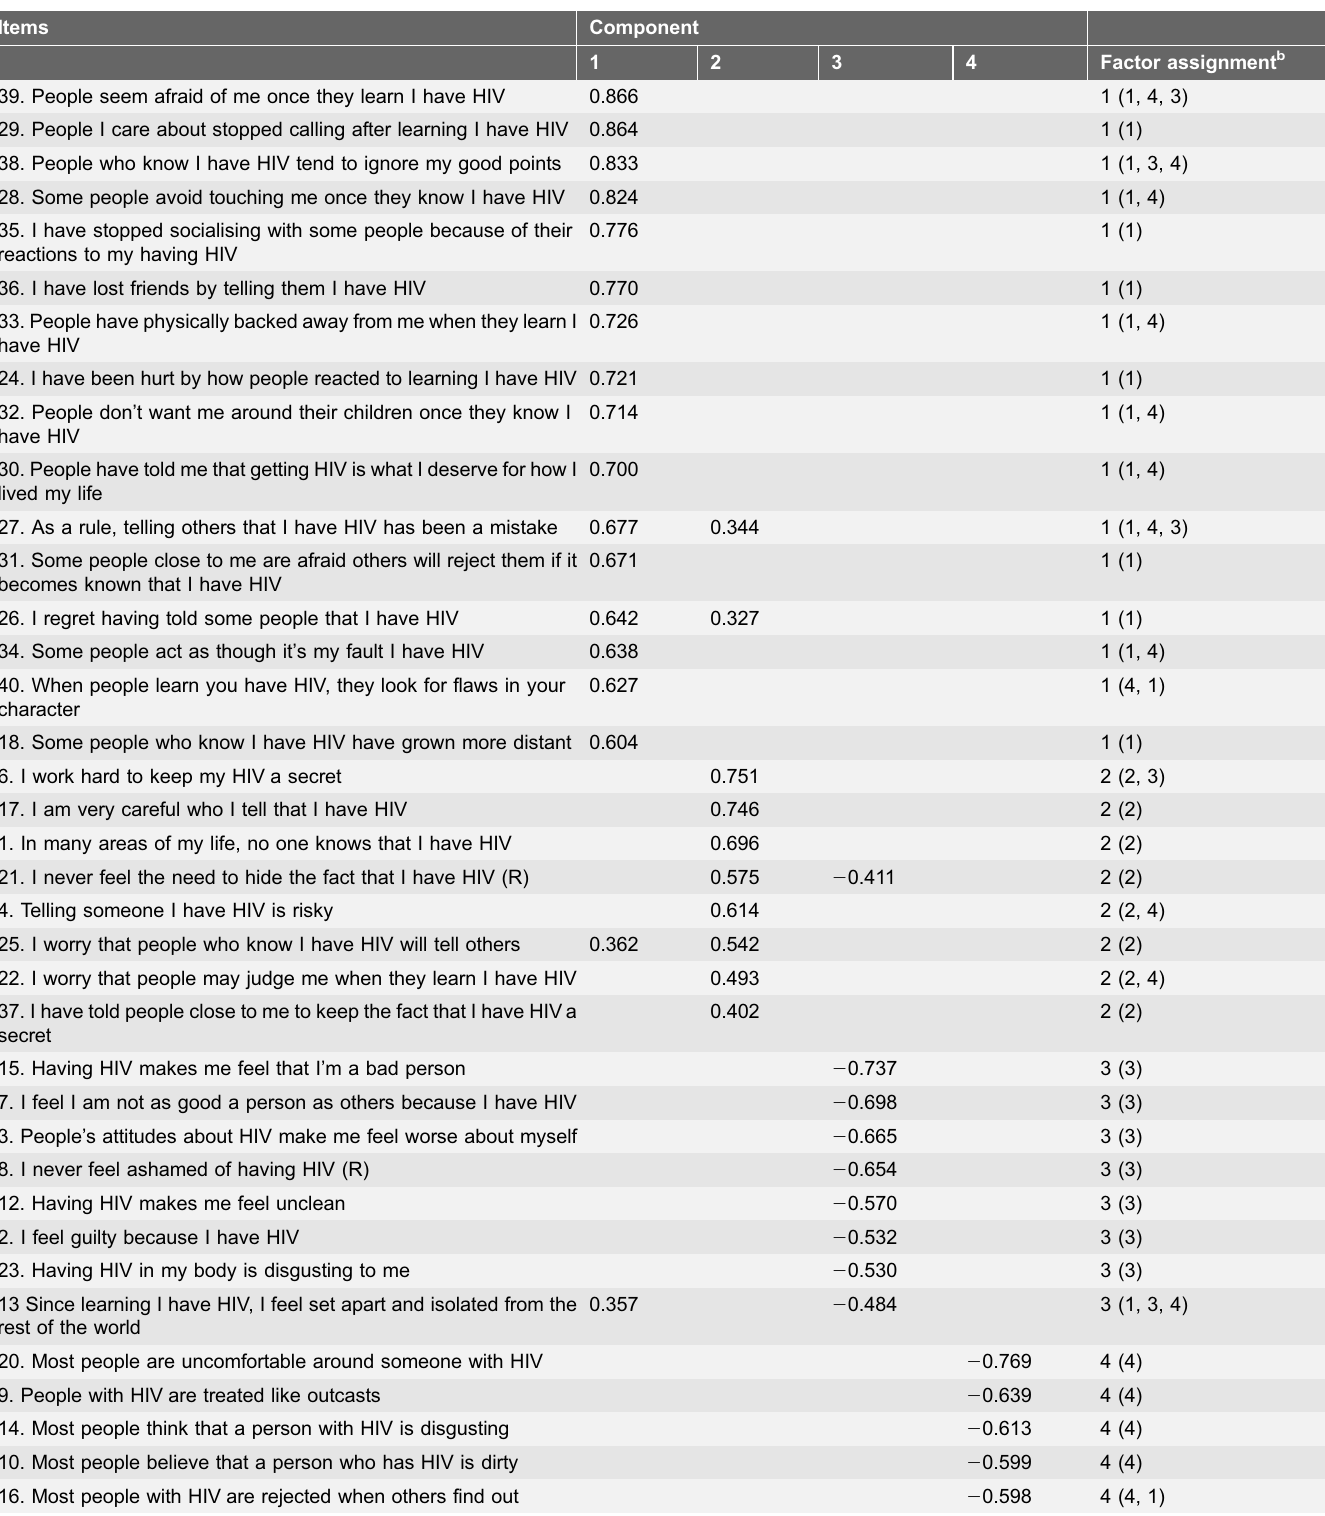
Table 2. Factor loadings for all 40 items in the HIV stigma scale. a